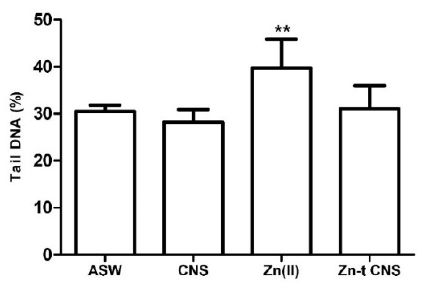
Figure 5. DNA primary damage (% tail DNA) in mussels’ gill cells after 48 h of exposure to the following experimental groups: Zn(II) (10 mg L − 1 of ZnCl 2 in ASW); Zn-t CNS (ZnCl 2 10 mg L − 1 contaminated ASW treated with CNS); CNS (ASW treated with only CNS). Results are shown as mean ± SD. (**) indicates significant differences with respect to the control group (ASW) ( p < 0.001).